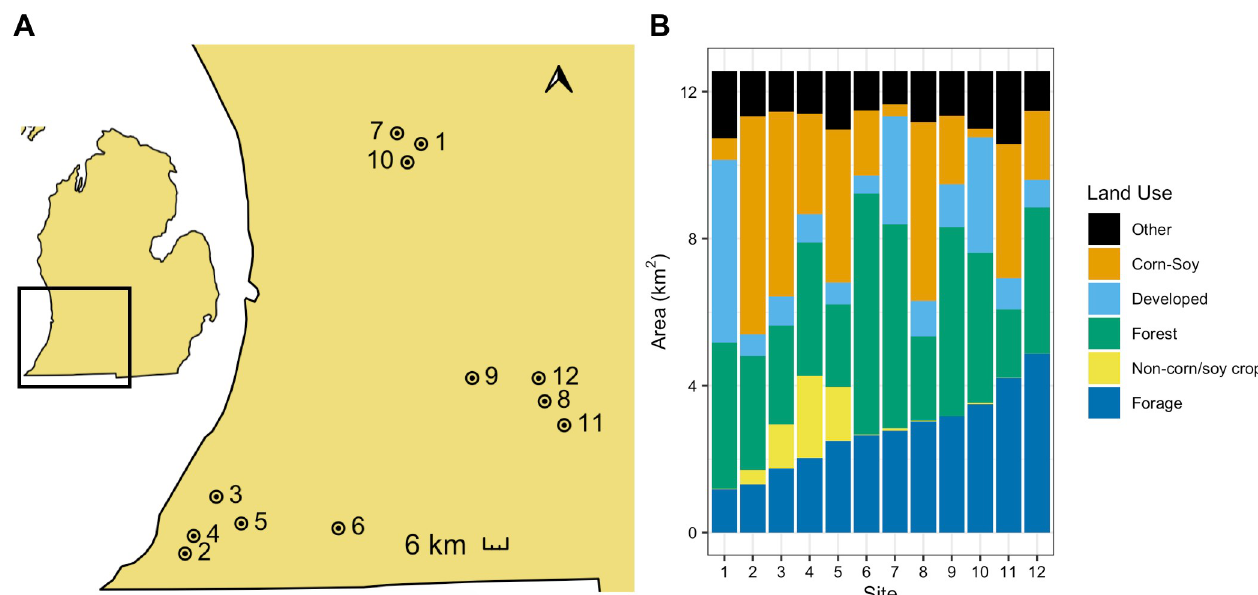
Fig 1. Location of 12 apiaries in Michigan, United States (A) and land use within 2 km (B) where honey bee and bumble bee colonies were sampled. Apiary locations are indicated with points, labeled with apiary number, and surrounded by a 2 km buffer. Land use is binned into six broad categories–forage, non- corn/soy crops, forests, developed, corn/soybeans, and all other land